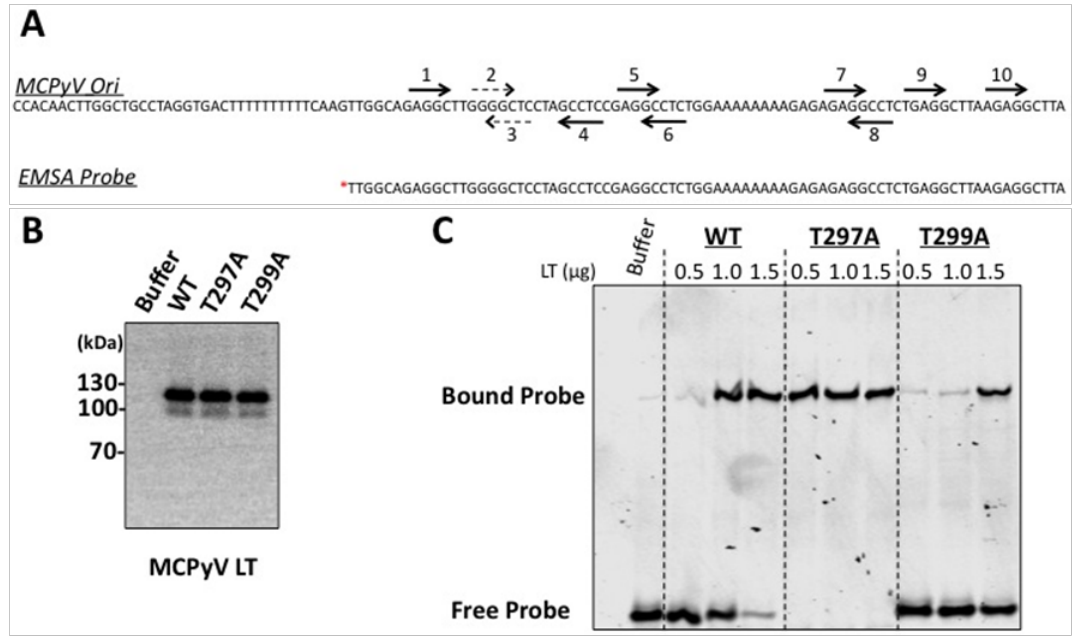
Figure 5. MCPyV LT phospho-mutants bind the viral Ori with different affinities. ( A ) Schematic of the MCPyV Ori and the EMSA Probe. Only one strand of DNA is shown for clarity. The MCPyV Ori sequence was cloned from the R17a isolate of MCPyV into a pcDNA4c vector [14]. This origin was used for replication assays (Figures 3 and 4). Consensus GAGGC pentanucleotide repeats which are recognized by the OBD of LT are marked with arrows and numbered as was reported by Kwun et al. [31]. Arrows with dashed lines indicate imperfect pentanucleotides. The EMSA Probe was generated by PCR amplification of the indicated region of the MCPyV Ori. This PCR product was 5' end-labeled with [ 32 P-γ] ATP using T4 polynucleotide kinase (indicated by red asterisk); ( B ) Western blot of purified MCPyV proteins (0.25 µg) used in EMSA. The buffer control contained residual TEV protease (also in LT samples); ( C ) Electromobility shift assays were performed with the EMSA probe in ( A ) and increasing amounts of MCPyV wild type or phospho-mutant LT affinity purified from HEK 293 cells. Reactions with buffer and residual TEV protease served as a negative control (first lane). Positions of free probe and LT bound probe are indicated. Data in ( B , C ) are representative of at least three